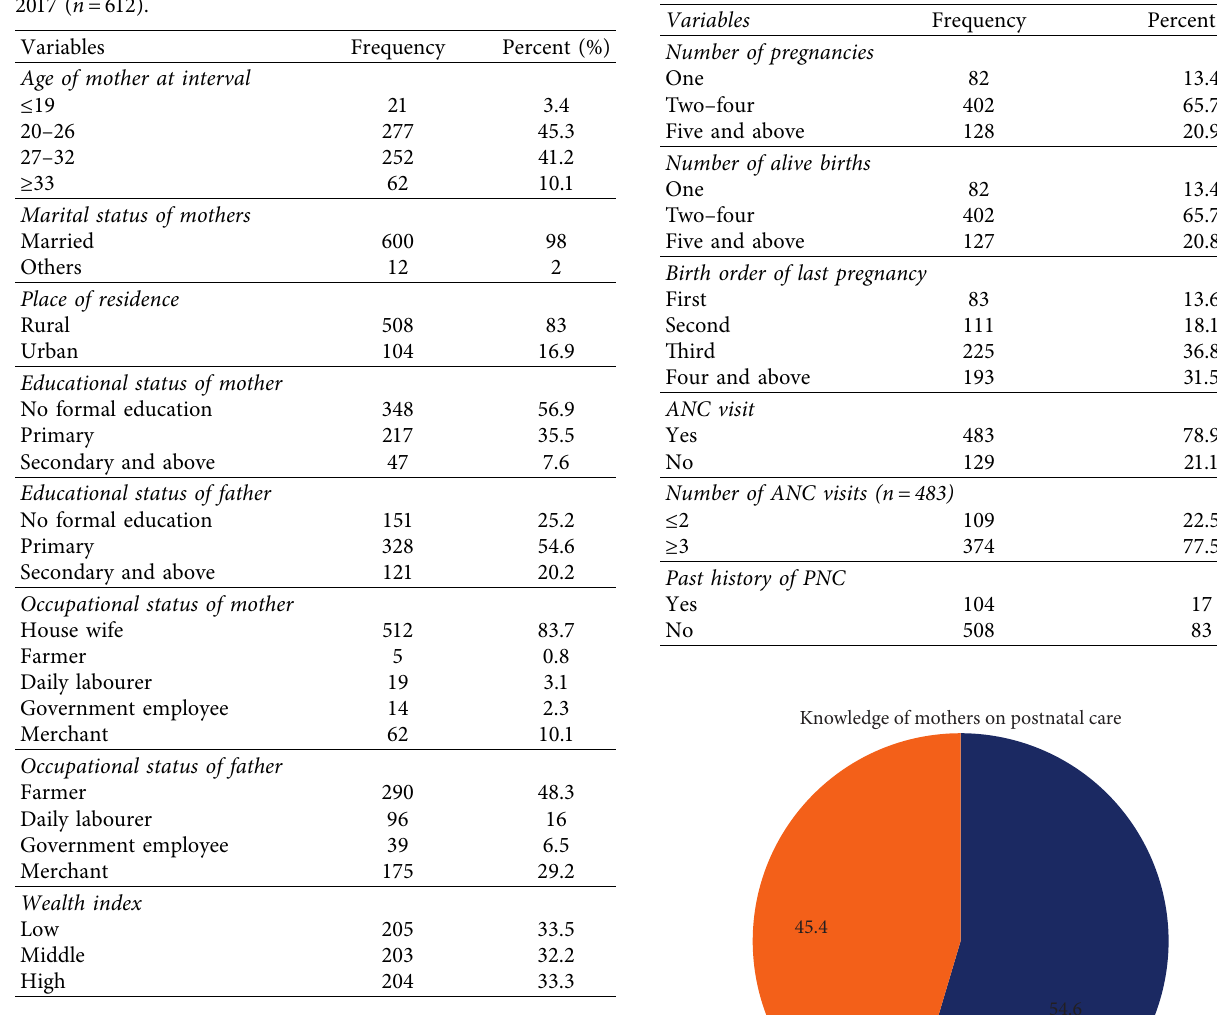
Table 2: Obstetric characteristics of mothers at Wonago District, South Ethiopia, 2017 ( n � 612).